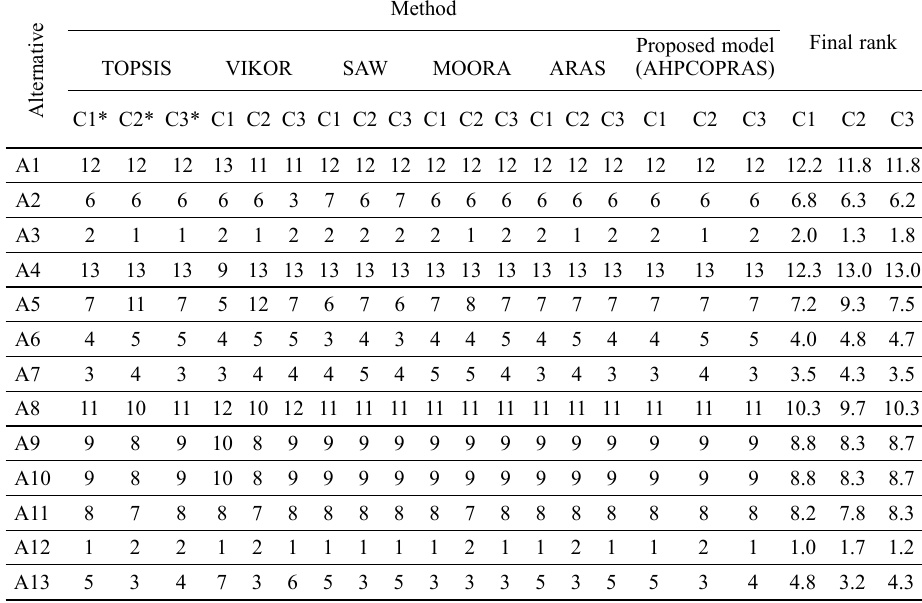
Table 12. Ranking of the alternatives in three different cases